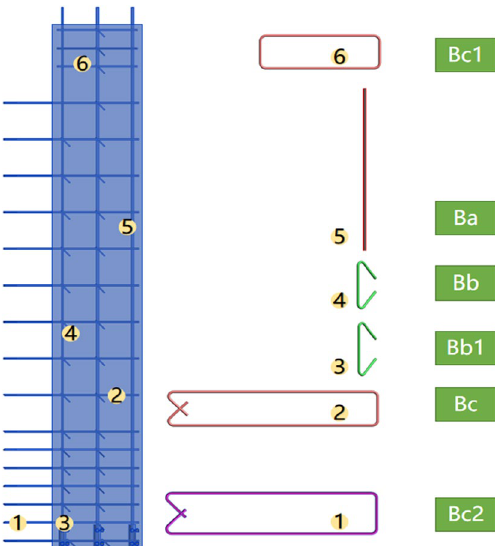
Figure 5. Information on the production of left-edge components.